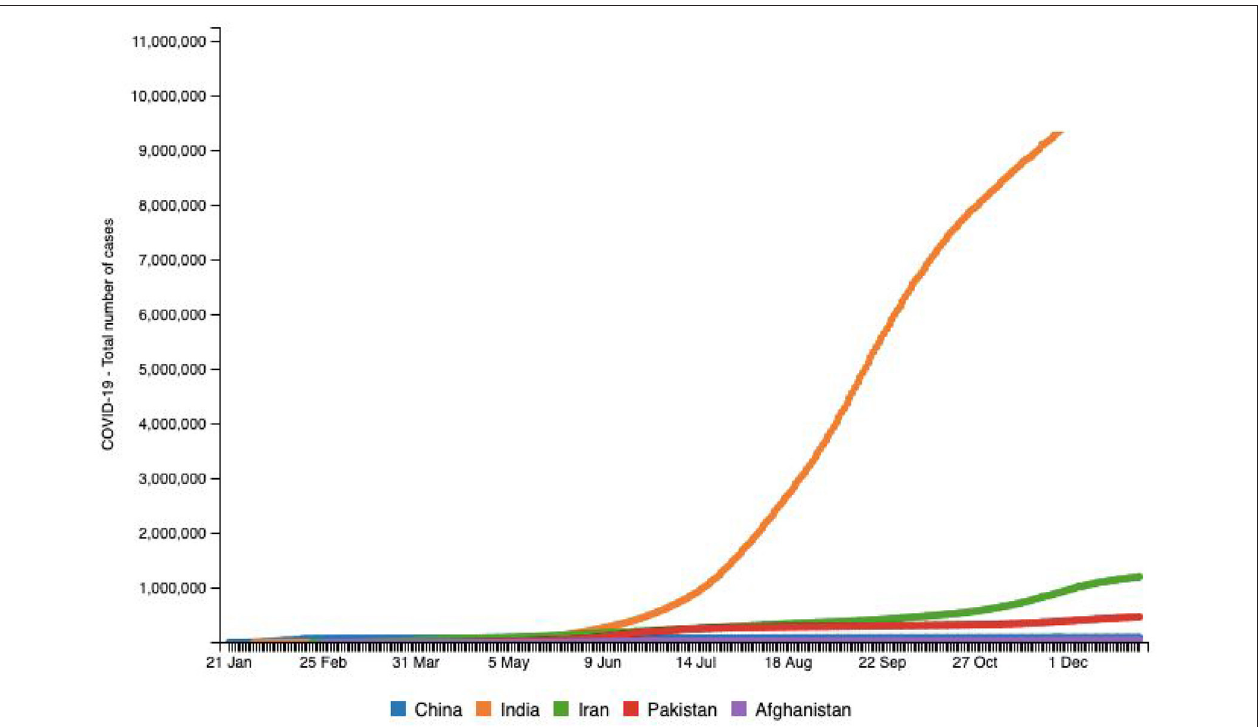
FIGURE 7 | Source: http://www.smaartrapidtracker.org, accessed on December 29, 2020. Total number of cumulative cases of COVID-19 in the world, China, India, Iran, Pakistan, and Afghanistan (January 21, 2020 to December 29,